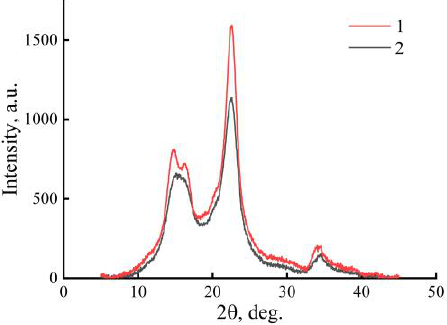
Figure 5. Powder diffraction patterns of flax noils (1) and wood (2) cellulose.